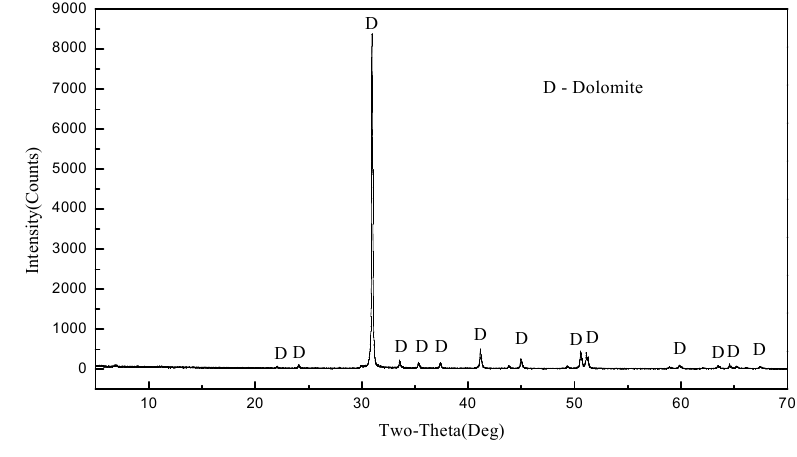
Figure 2. XRD pattern of the dolomite sample.